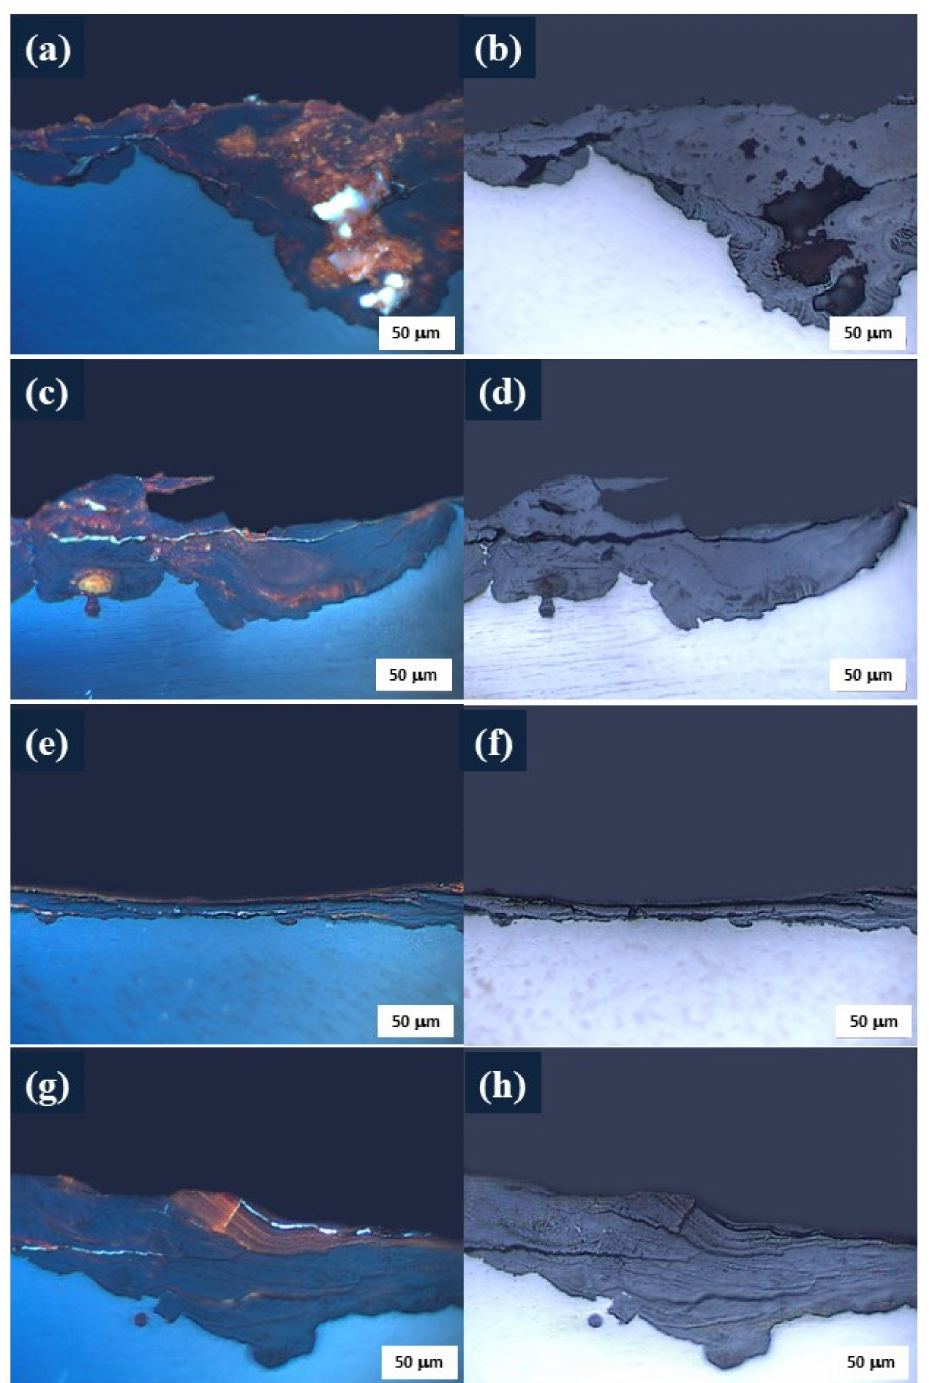
Figure 4. Optical micrograph of rust formed on the steels exposed for 36 months in different environments of Chile: ( a , b ), Arica; ( c , d ), Quintero; ( e , f ), Laja; and ( g , h ), Antarctic Stations. Magnification 200 ×